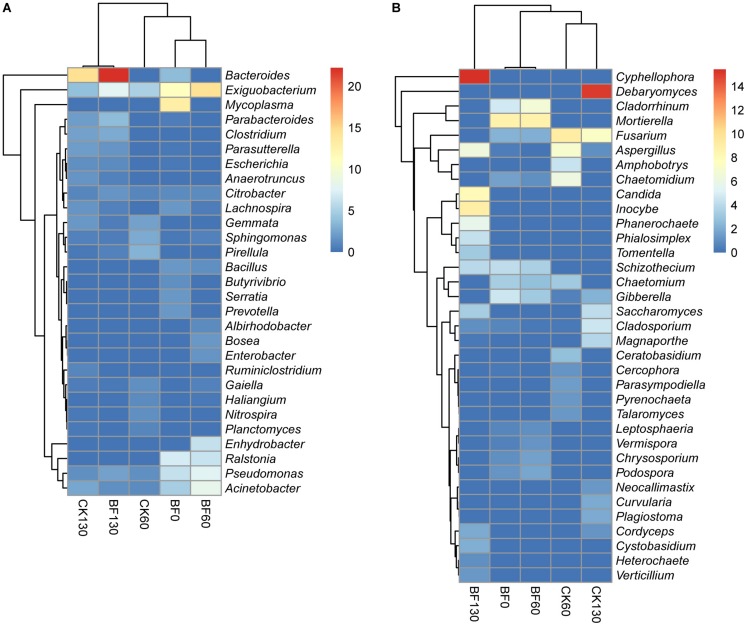
Heatmap analysis of bacterial (A) and fungal (B) genera.